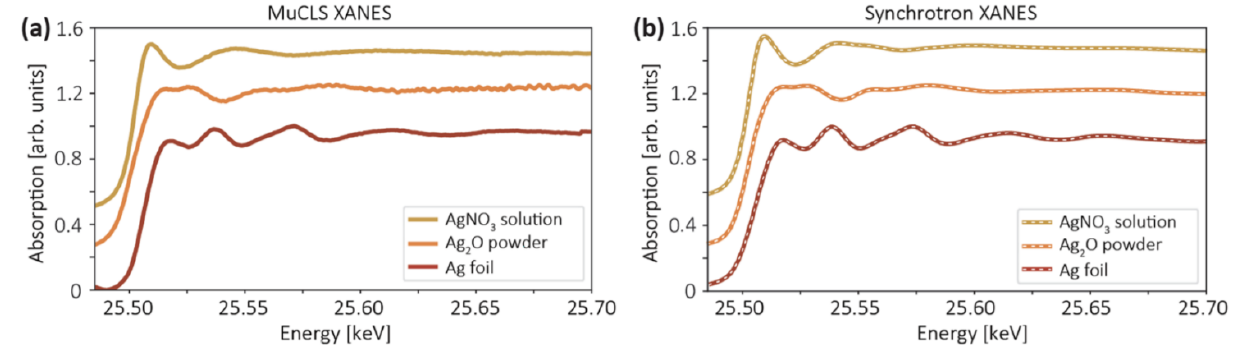
Figure 21. XAS spectra collected for the homogenous Ag foil and AgNO 3 and inhomogeneous Ag 2 O powder samples ( a ) on the low-scale laboratory experimental setup with ICC as the X-ray source, and ( b ) on a JSRRI synchrotron beamline. Figure reproduced with permission from Huang et al. [162]. Copyright (2020) Springer Nature.